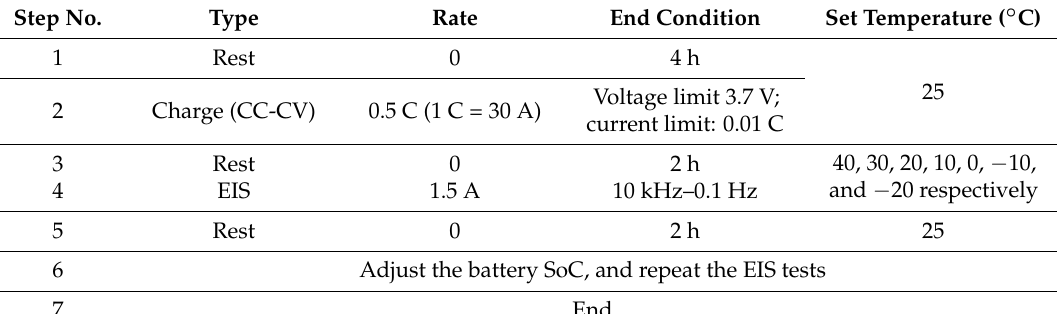
Table 2. Electrochemical impedance spectroscopy (EIS) test procedures A1 at various state of charge (SoC) and temperature. CC-CV: constant current-constant